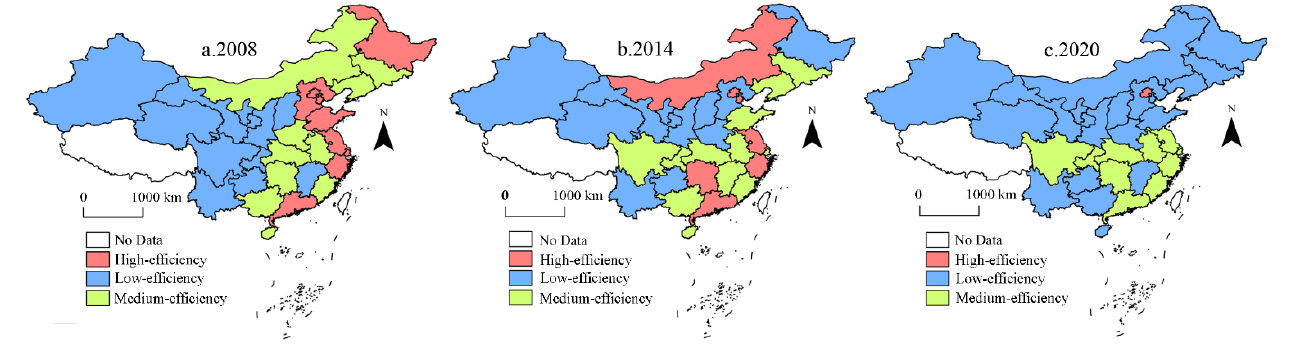
Figure 2. CEE in mainland China during 2008 –